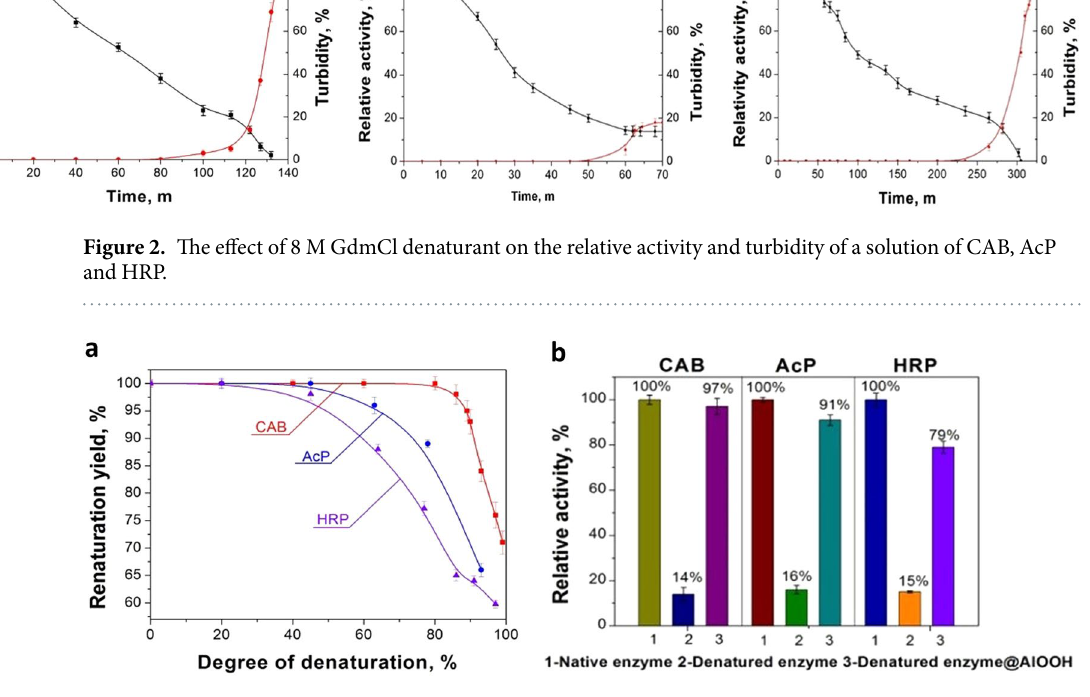
Figure 3. ( a ) Alumina NP-assisted renaturation yield as a function of degree of denaturation of CAB, AcP, HRP. ( b ) Renaturation yields of CAB, AcP and HRP molecules before separation from alumina